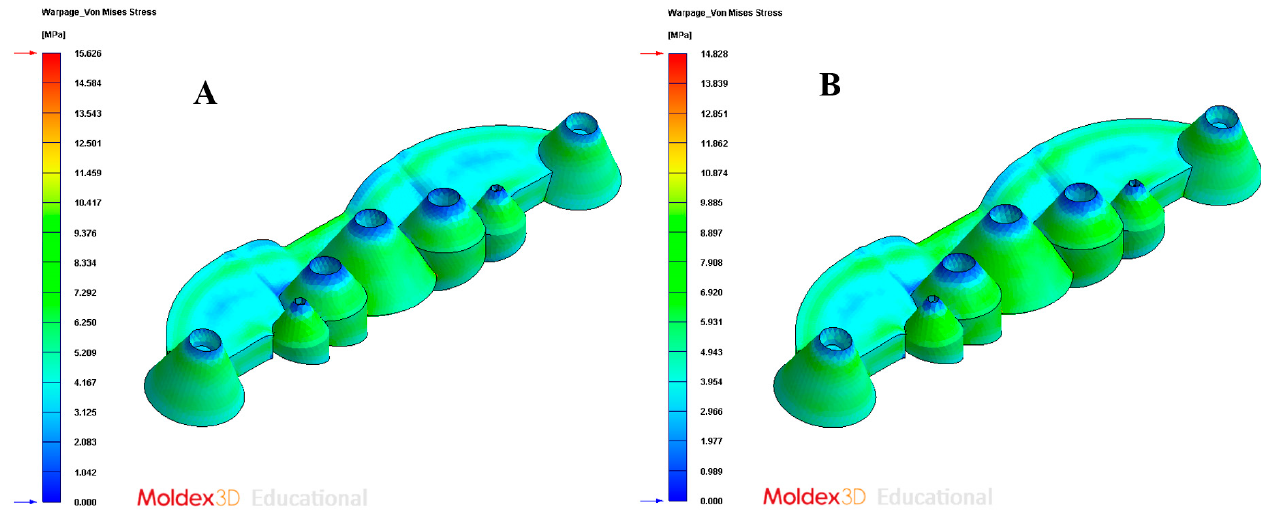
Figure 27. Warpage von Mises stress. ( A ) Traditional cooling; ( B ) conformal cooling. Table 11. Comparison of the maximum values of the thermal and mechanical variables obtained after the numerical analysis for each cooling system design.